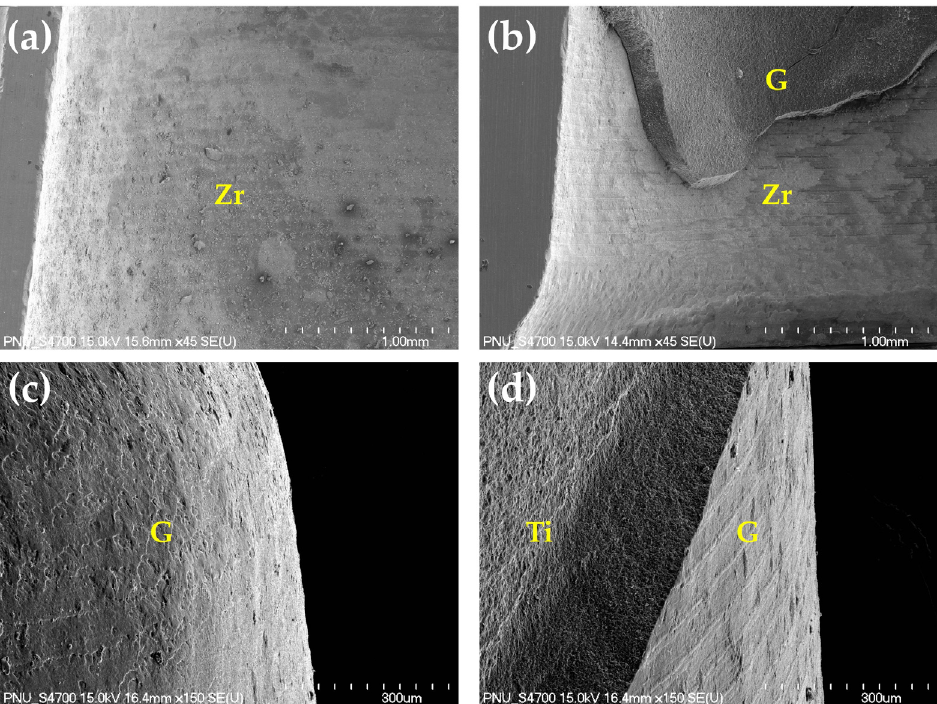
Figure 11. ( a, b ) Representative FE-SEM images (45×) of the inner surface for zirconia crown in thermocycling after the RS test. ( a ) Adhesive failure of the Control group. ( b ) Mixed failure of the NTP group. ( c, d ) Representative FE-SEM images (150×) of the titanium abutment surface in thermocycling after the RS test. ( c ) The surface where adhesive failure between the zirconia crown and the resin cement occurred in the Control group. The entire surface of the titanium abutment was covered with the resin cement. ( d ) The surface where the mixed failure occurred in the NTP group. Zr, zirconia surface. G, G-CEM LinkAce. Ti, titanium abutment.